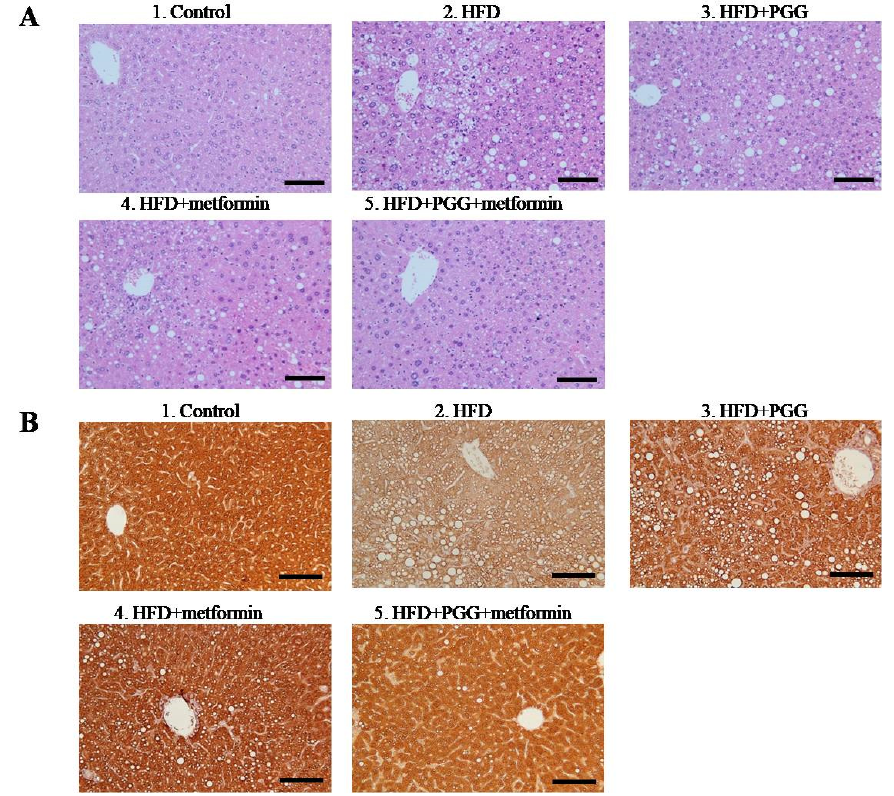
Figure 2. Histopathological analysis of liver sections received indicated treatment. ( A ) H&E stain- ing. ( B ) Immunohistochemical staining of GNMT in the liver tissue. (Scale bars = 100 μ m, N = 10/group).